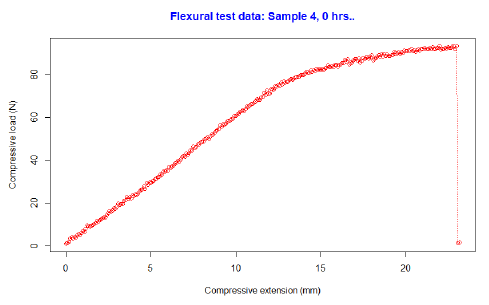
Figure 2. Flexural test.